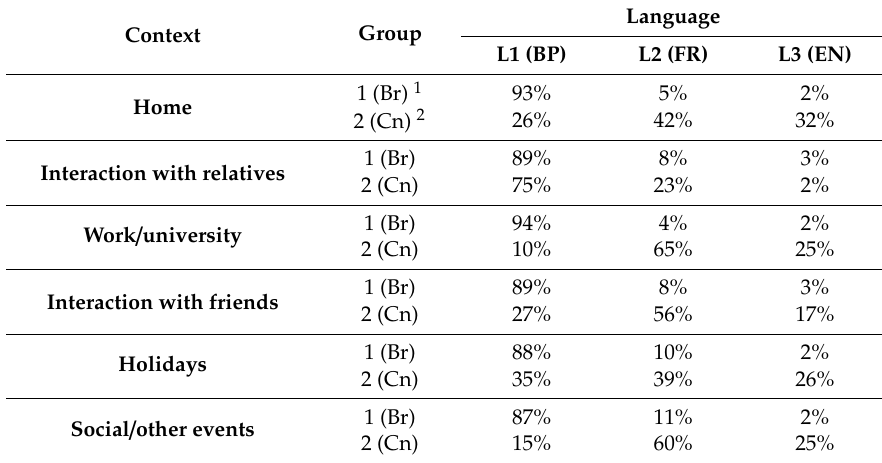
Table 1. Frequency of use per language and group. BP: Brazilian Portuguese, FR: French, EN: English.